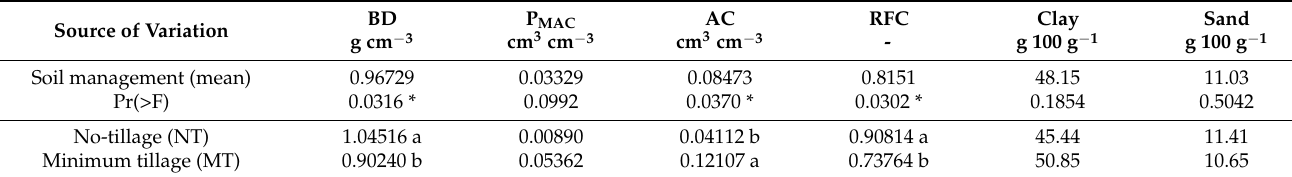
Table 2. Results of nested analysis of variance carried out on soil physical and hydrological parameters. Source of Variation